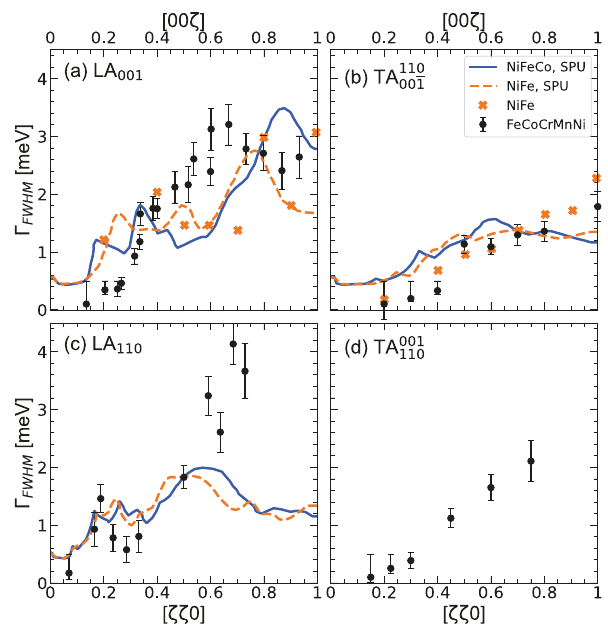
Fig. 6 | Phonon Linewidthsat room temperature. Intrinsic phonon linewidths of FeCoCrMnNi, measured by inelastic X-ray scattering at 300 K for ( a ) LA 001 , ( b ) , ( c )LA 110 ,and ( d )TA 001 100 .ExperimentaldataonbinaryNiFe togetherwithSPU TA 110 001 calculations predictions for NiFe and NiFeCo linewidths after Mu et al. 22 are also reported.(SPUcalculationswerenotmadefortheFeCoCrMnNipolarizationshown in ( d )). Error bars correspond to the standard deviation of the fi tted